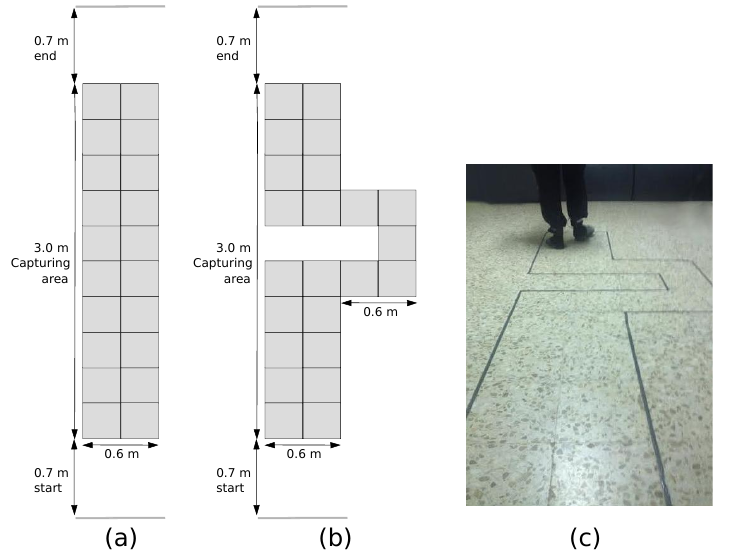
Figure 10. Straight-line path ( a ). Turning path ( b ). During the experiment ( c